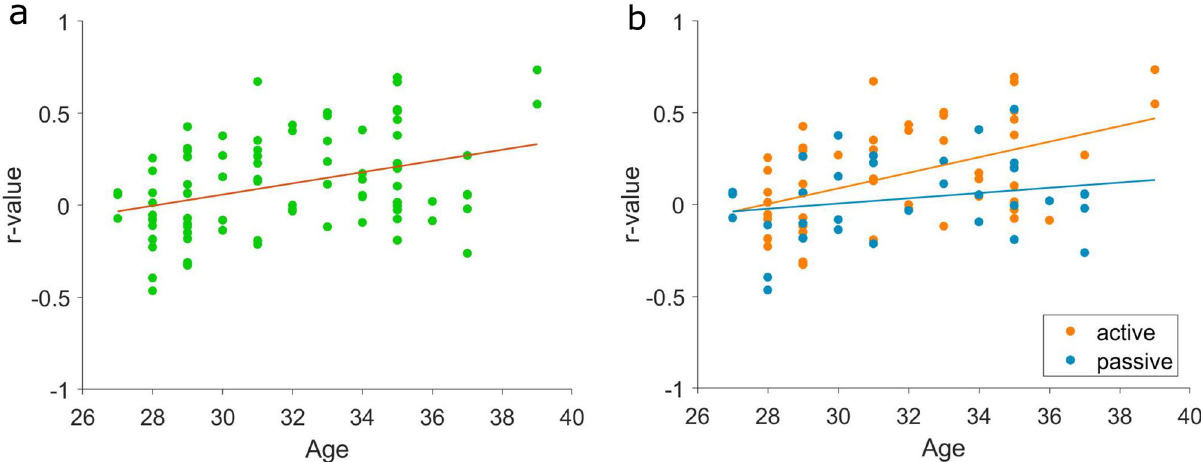
Figure 6. ( a ) Increase of the correlation cardiogram-actogram regardless the fBS. ( b ) This increase is driven by the significant increase of correlation during active